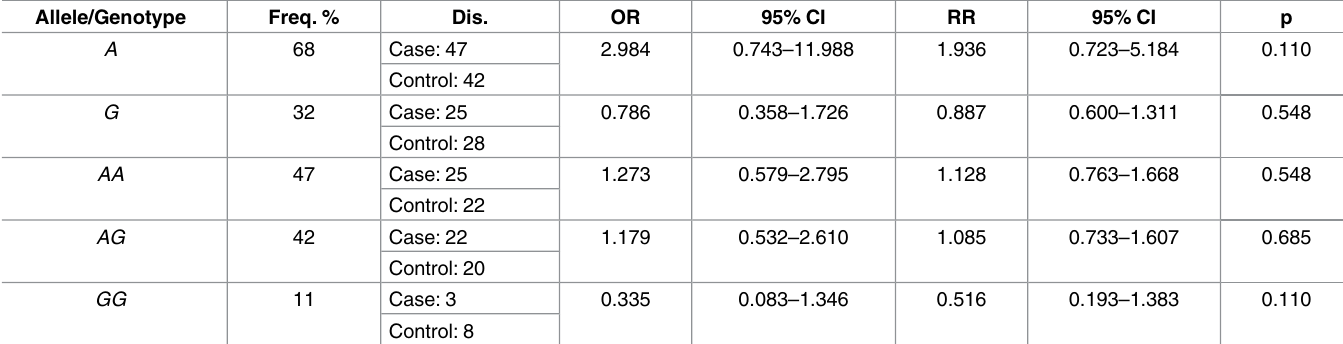
Table 4. Allele and genotype analysis of the SLC22A16 gene polymorphism (rs12210538A/G) . Allele/Genotype Freq. %